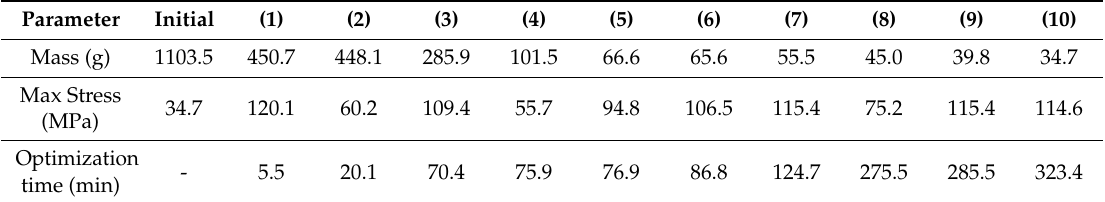
Table 3. The results of all design processes of the Hollow Plate optimization.